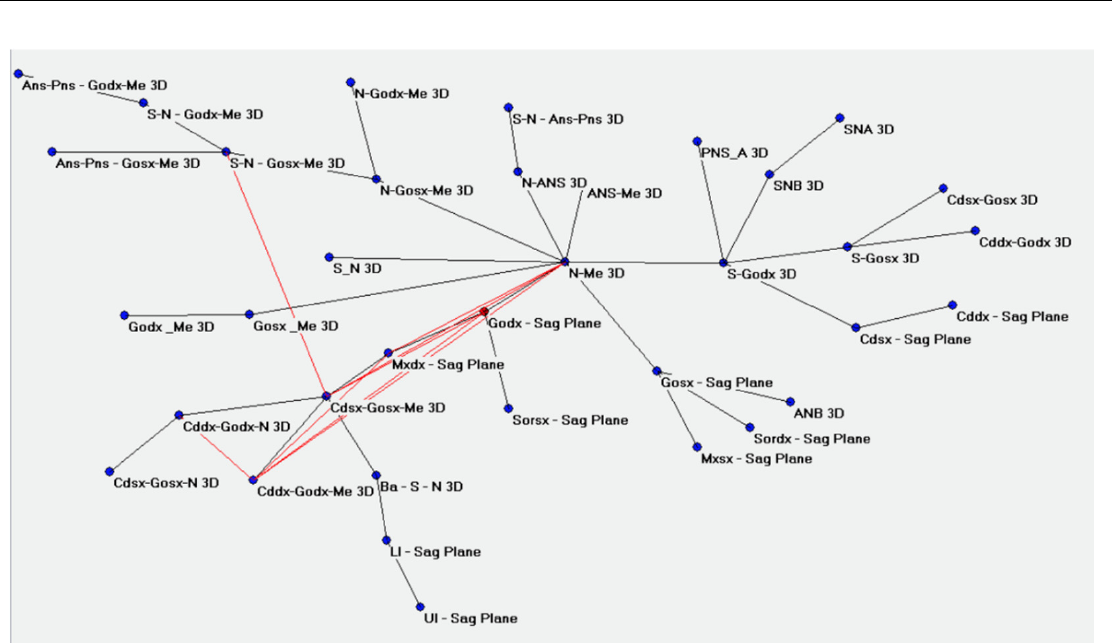
Figure 2. Right go-sagittal plane betweenness centrality displayed on Pajek.